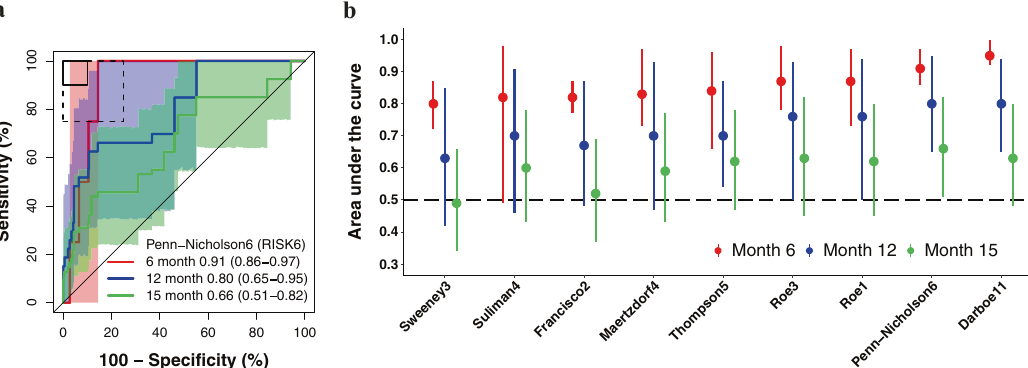
Fig. 4 Parsimonious signature prognostic performance for incident TB in people without HIV. a Representative receiver operating characteristic (ROC) curves depicting prognostic performance (area under the curve, AUC, with 95% CI) of the parsimonious signature with the best prognostic performance (Penn-Nicholson6/RISK6 signature) for incident TB diagnosed on two or more liquid culture-positive or Xpert MTB/RIF-positive sputum samples (primary endpoint) through 6, 12, and 15 months follow-up in the CORTIS-01 study of people without HIV. ROC curves for the other signatures are in the Supplementary Information (Fig. S7). The shaded areas represent the 95% CIs. The solid box depicts the optimal criteria (90% sensitivity and 90% speci fi city) and the dashed box depicts the minimal criteria (75% sensitivity and 75% speci fi city) set out in the WHO Target Product Pro fi le for an incipient TB test 21 . b Summary of signature prognostic performance in the order of primary endpoint AUC estimates through 12 months follow-up. The prognostic AUC estimates through 6 and 15 months are also shown. The midline indicates the AUC estimate, the error bars indicate the 95% CIs, and the black dashed line indicates an AUC cut-off of 0.5.